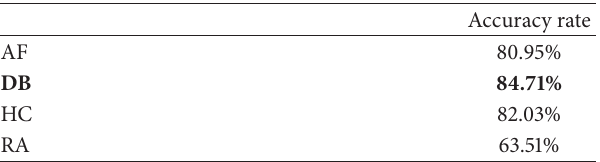
Table 2: Comparison of results between different clustering meth- ods in second evaluation